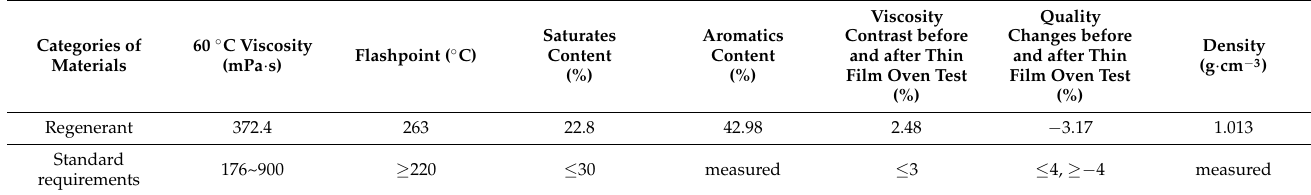
Table 3. Property indexes of